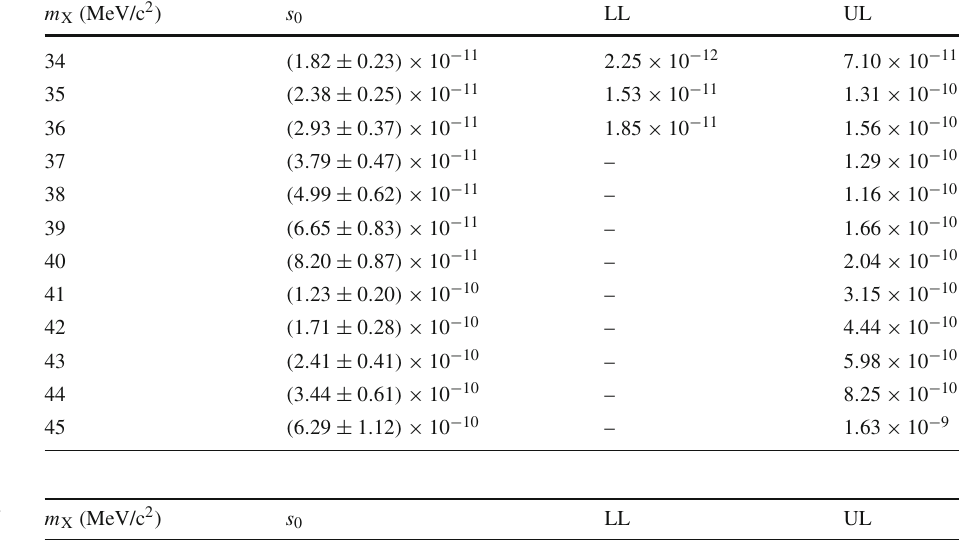
Table 5 Results for τ X = 40